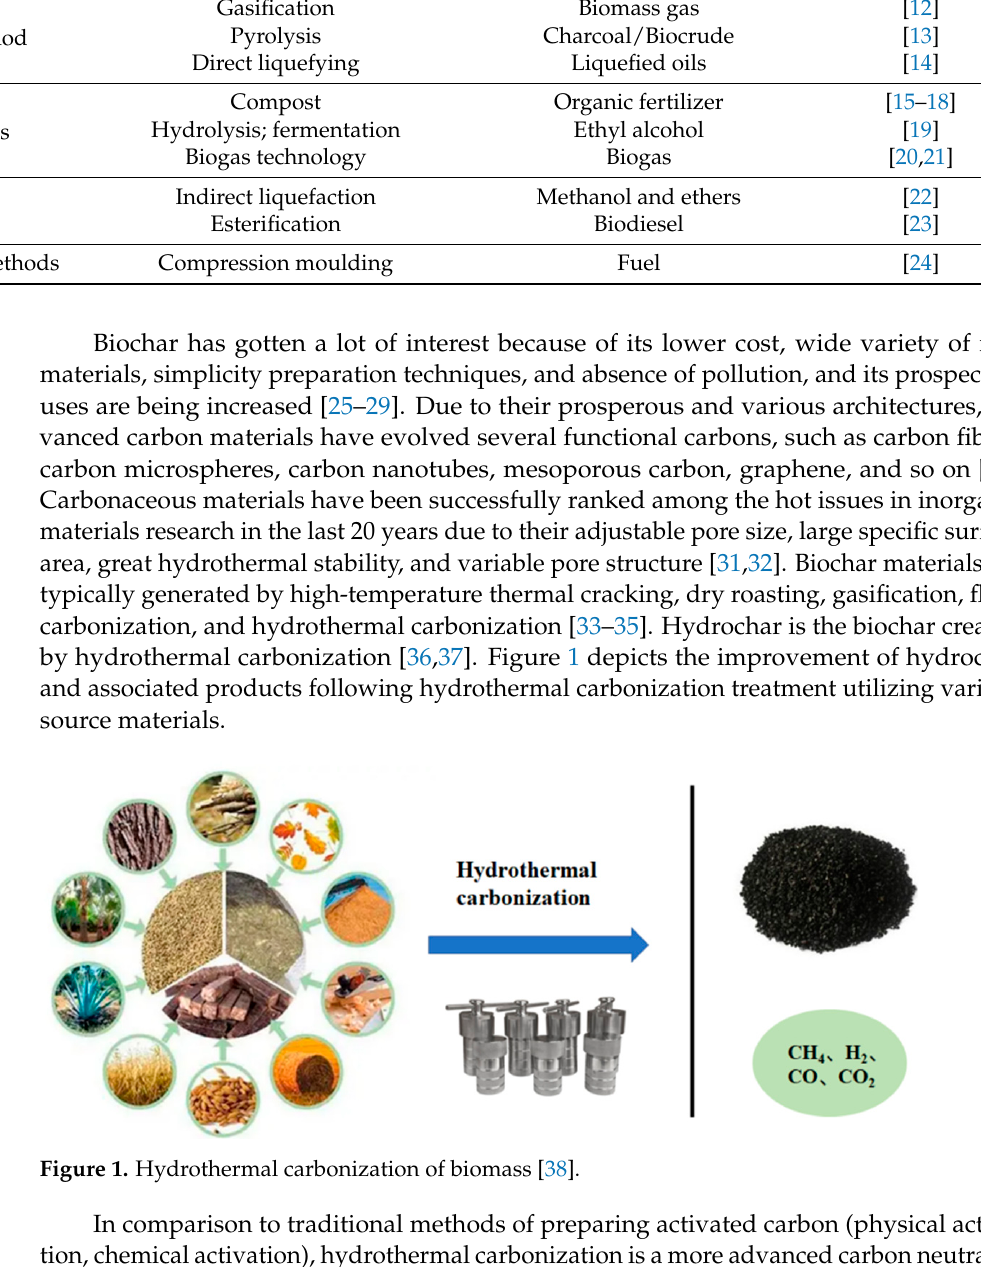
Table 1. Biomass waste resource utilization methods and products.